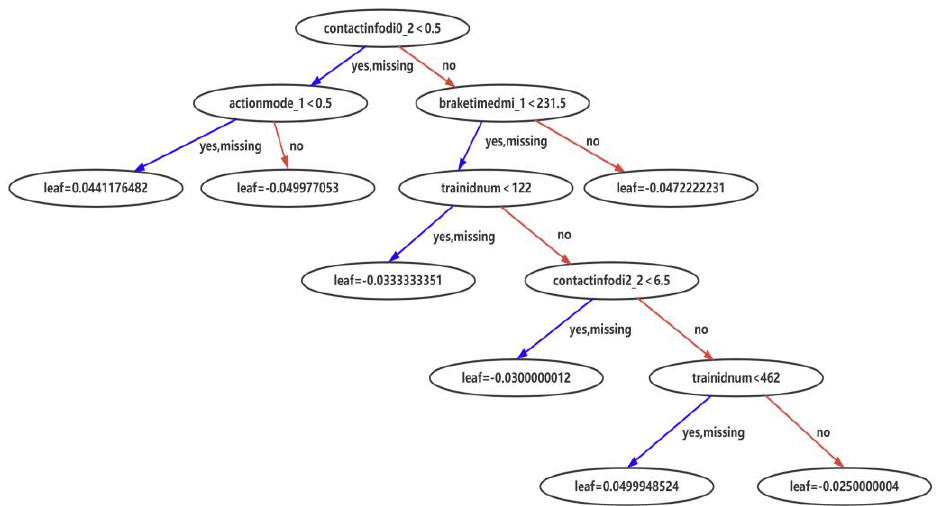
Figure 11. Typical sub-model (tree) of the ensemble by the training with 2018-T(A).